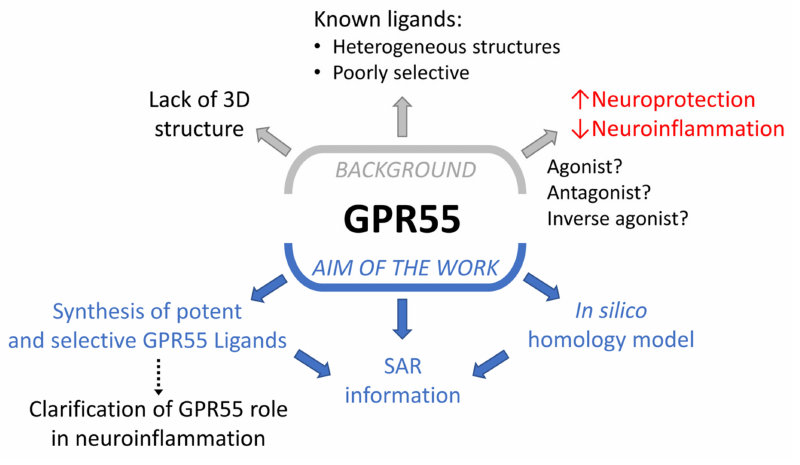
Figure 1. Background and aim of this